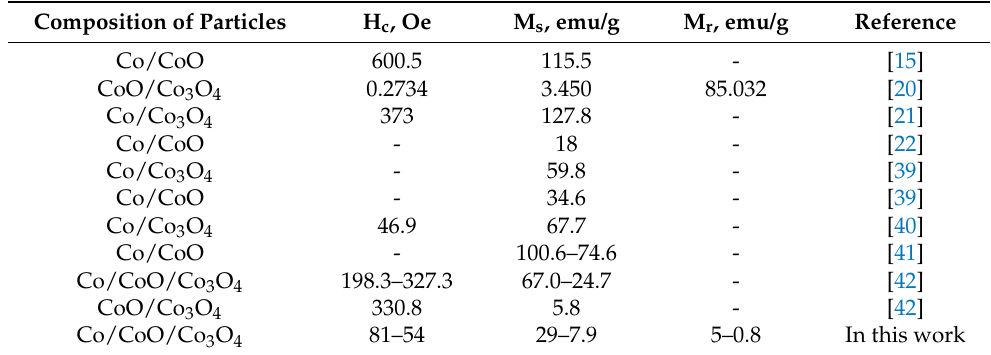
Table 3. Magnetic characteristics of composites based on cobalt compounds. Composition of